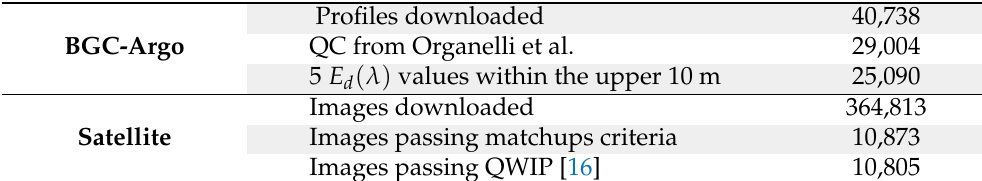
Table A1. Number of downloaded profiles and